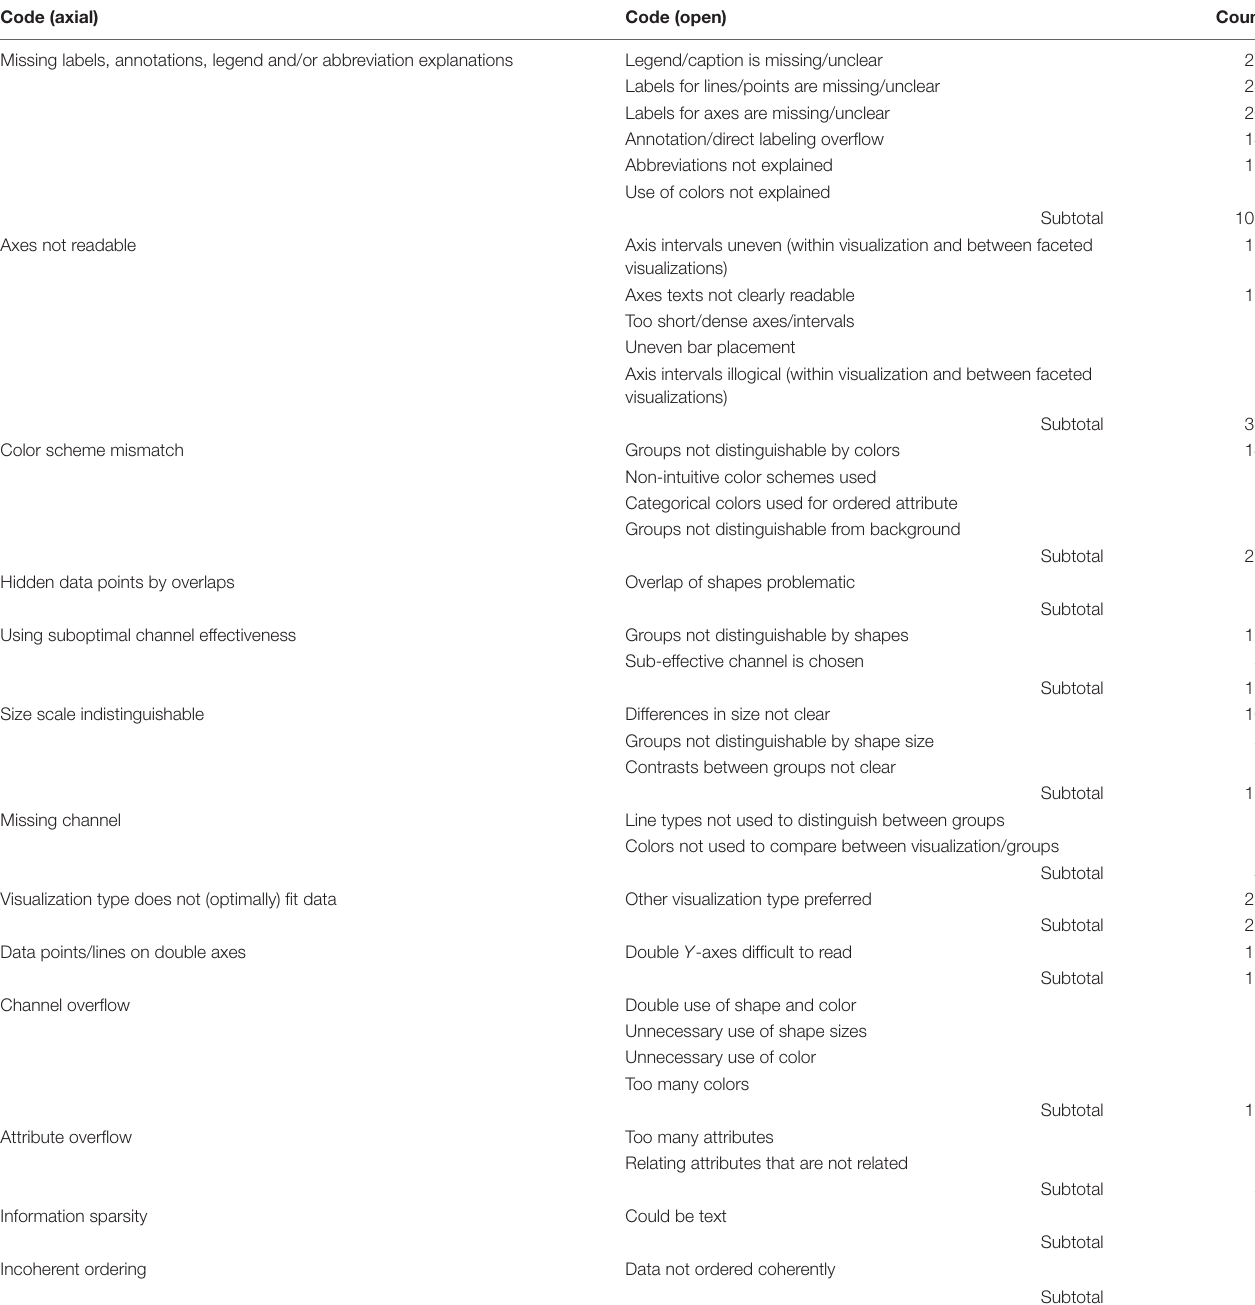
TABLE 1 | Identified problems in stewardship data visualization. Code